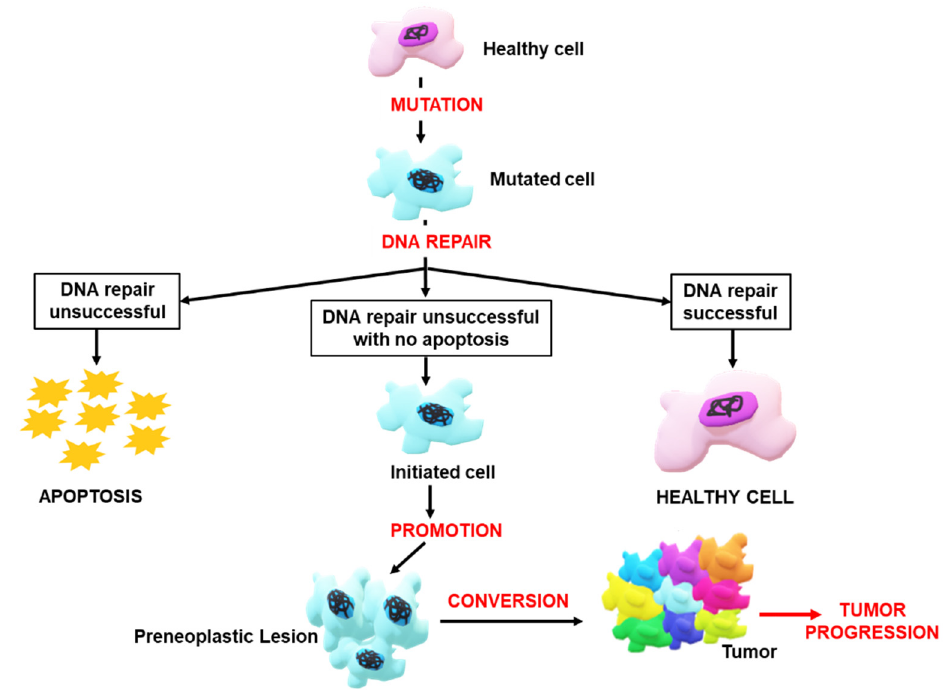
Figure 3. Illustration of the stages in the progression of cancer.